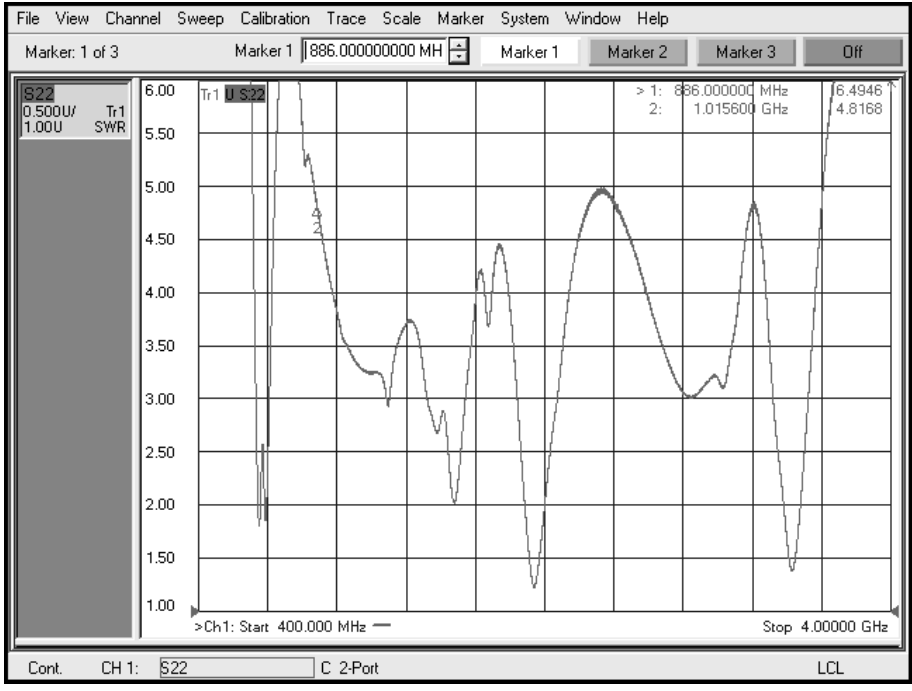
Fig. 3. S22 parameter for 2 cascade converter.